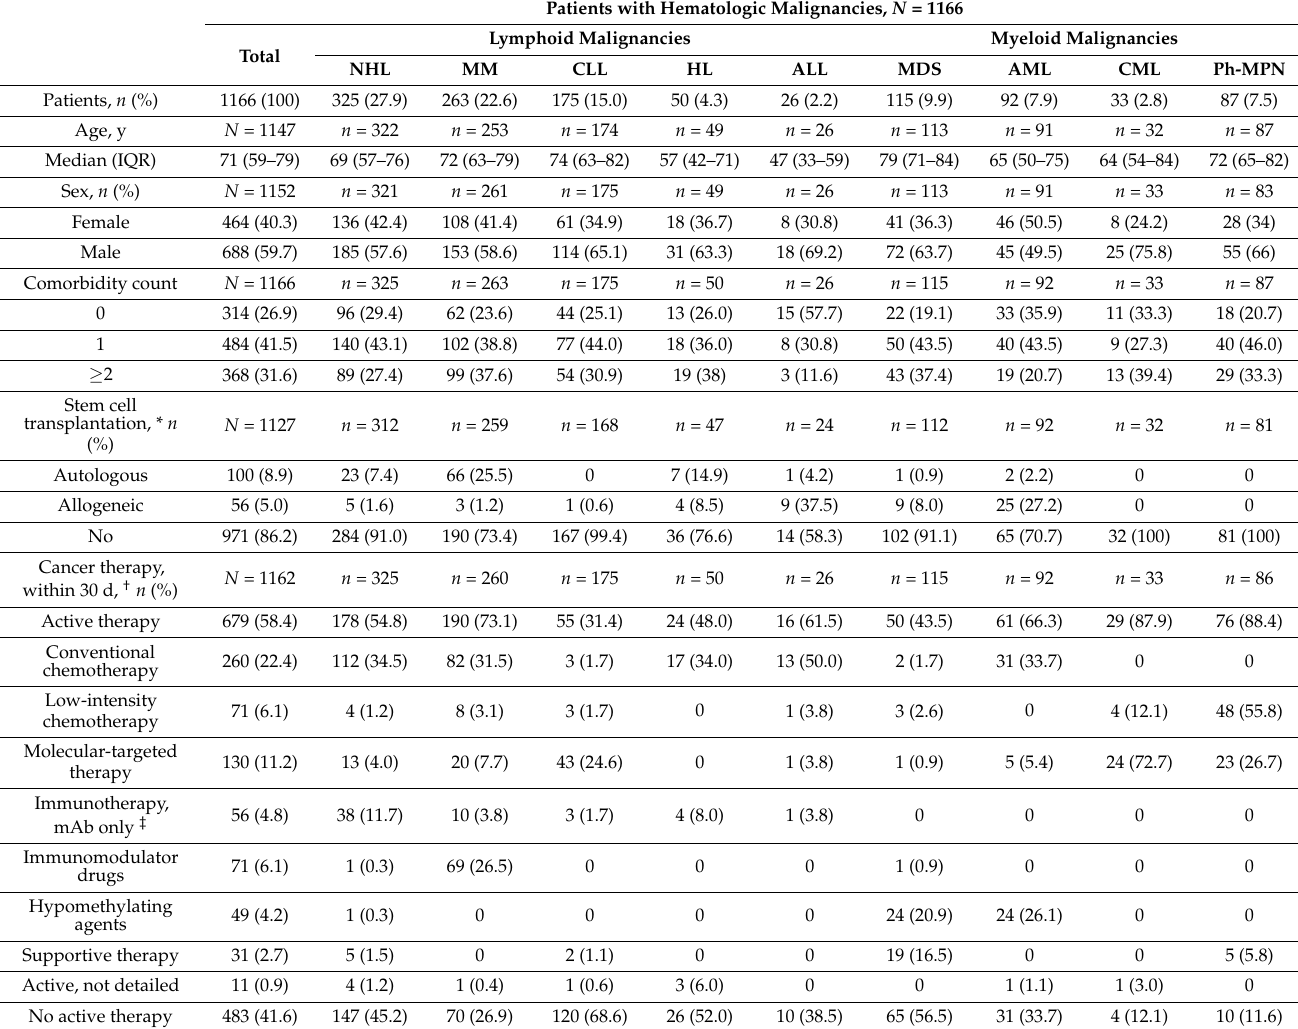
Table 1. Baseline characteristics of, and therapy received by, patients with hematologic malignancies and COVID-19. Patients with Hematologic Malignancies, N =